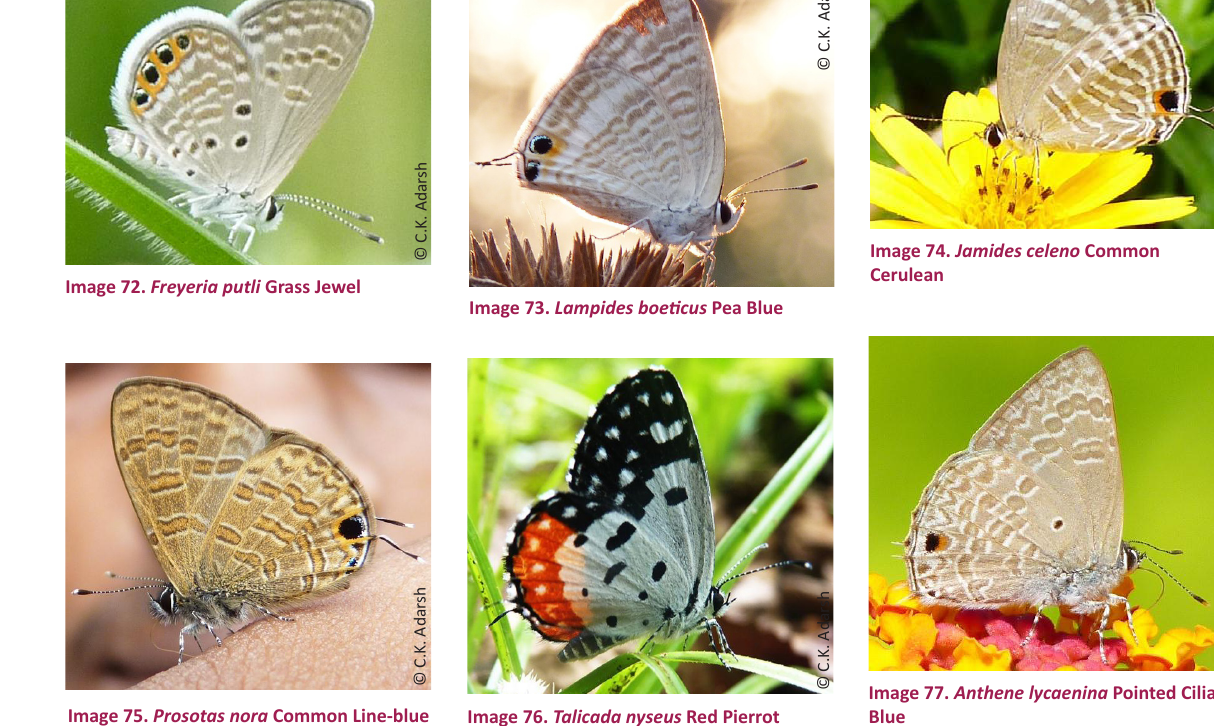
Image 76. Talicada nyseus Red Pierrot